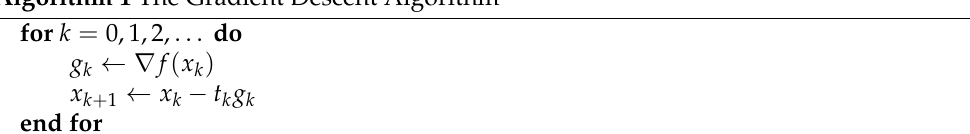
Algorithm 1 The Gradient Descent Algorithm